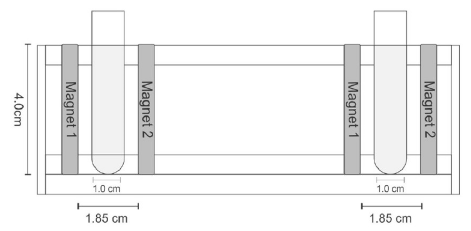
Figure 1. Magnets arrangement and tubes on support, with frontal view of support of tubes and spatial measurements.